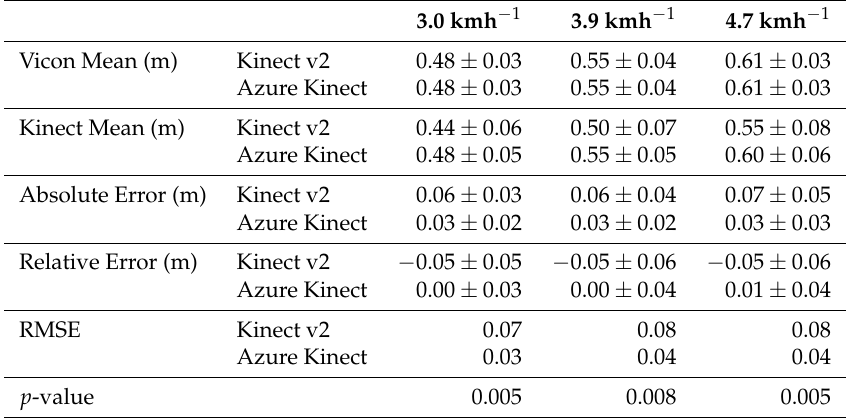
Figure 9. Step Length for Kinect v2 and Azure Kinect aggregated over all three speeds. Table 4. Step length gait parameter